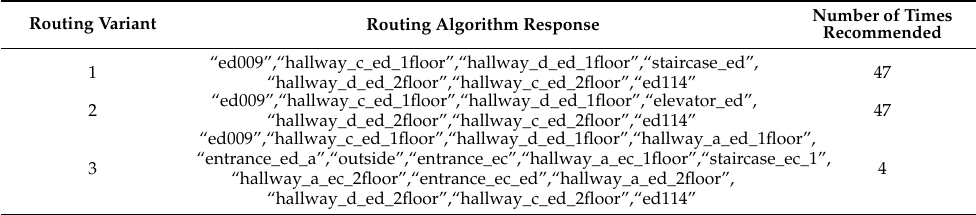
Table 4. Responses for 100 requests with Policy